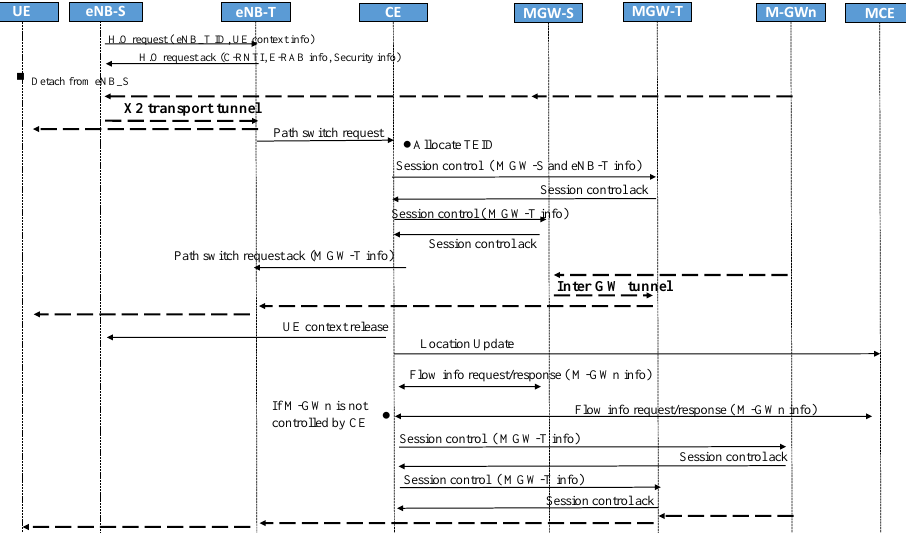
Figure 9. The procedure of the handover with gateway relocation in the proposed 5G concept.